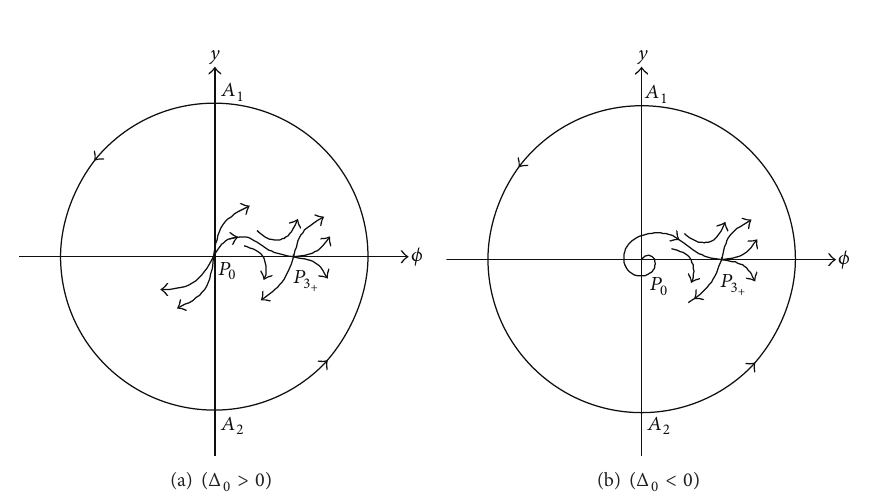
Figure 6: ( 𝛽 > 0 , 𝑎 < 0 , 𝑏 > 0 , 𝑐 < 0 , Δ > 0 ).